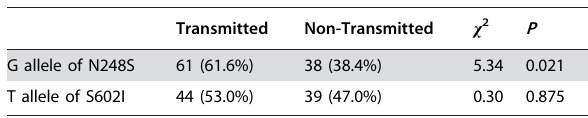
Table 3. TDT analysis of N248S and S602I in families with